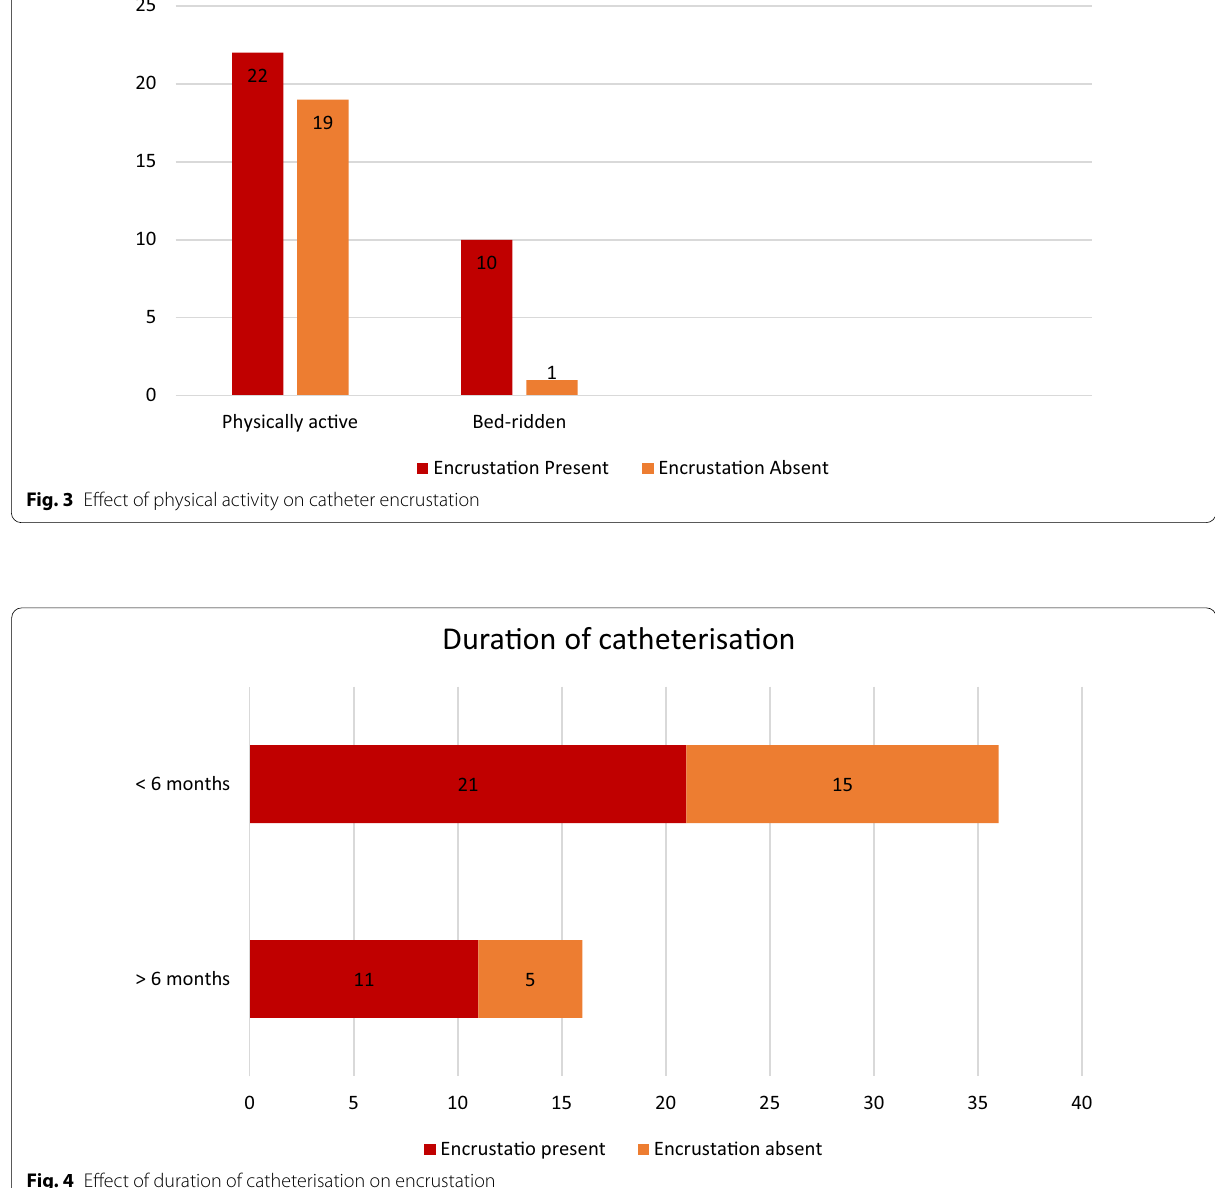
patients having a single catheter for more than 30 days (86%) when compared to patients having of particular catheter for a shorter period less than 30 days (43.3%).